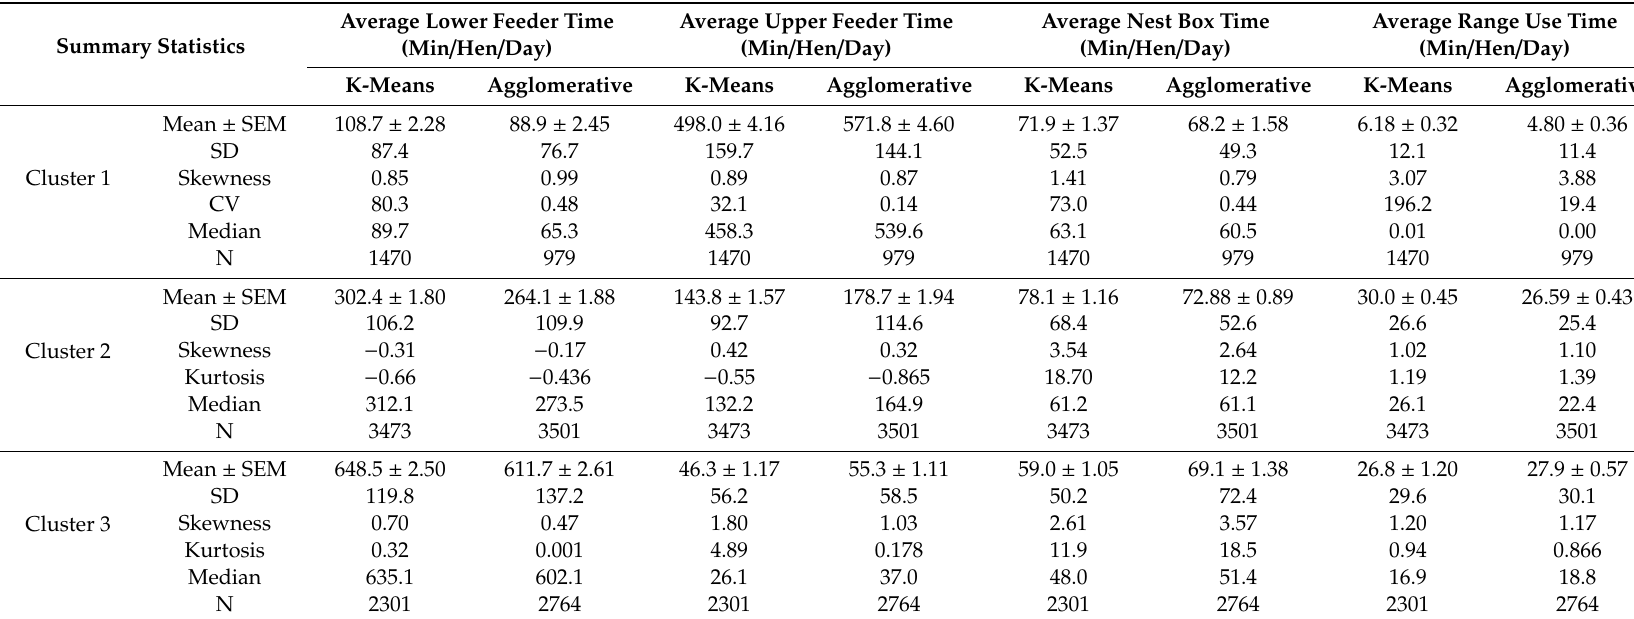
Table 1. The descriptive statistics of the K-means and agglomerative clusters of the free-range flocks using daily mean time duration in each zone from 18–22 weeks of age (pre-laying period). CV = coe ffi cient of